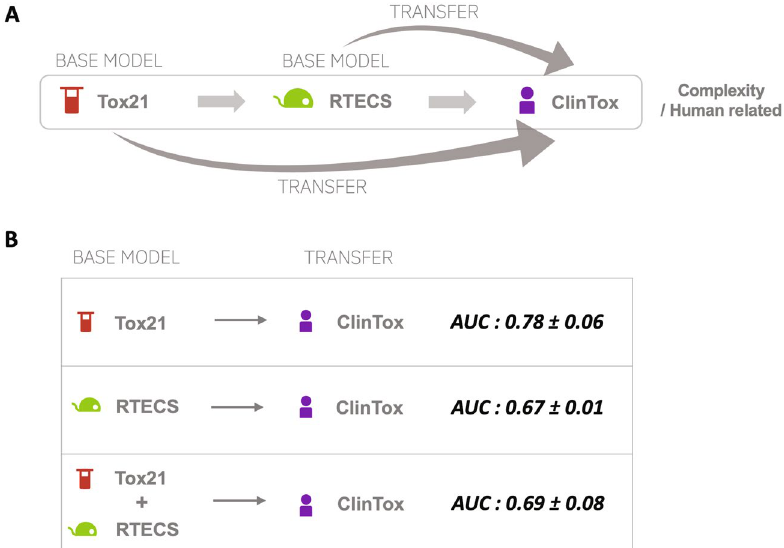
Figure 4. Comparing transfer learning to predicting clinical toxicity from base in vitro and in vivo models. ( A ) Schematic of transfer learning model, with a base model pre-trained on either on in vitro or in vivo data transferred to predicting clinical toxicity. ( B ) AUC results on the ClinTox (clinical) tasks with one epoch training during transfer learning to ClinTox tasks.